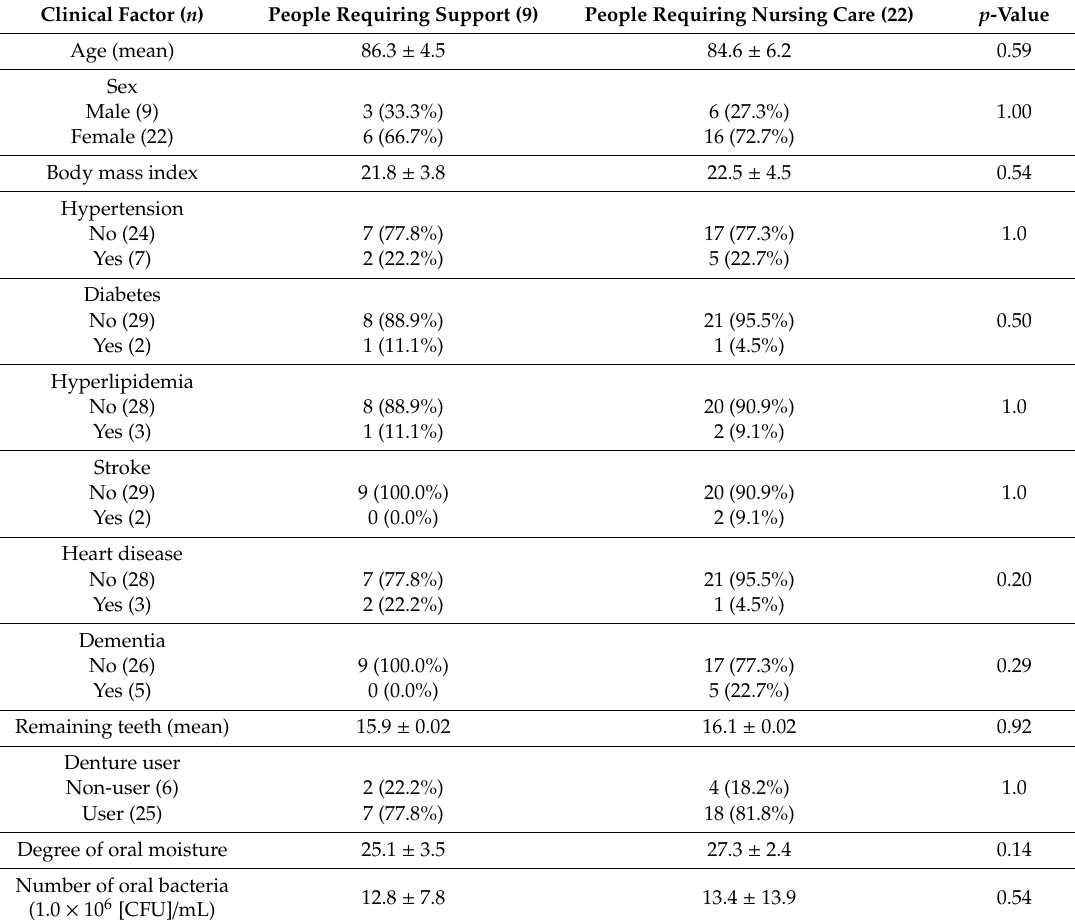
Table 3. Clinical characteristics of older people who required long-term support or nursing